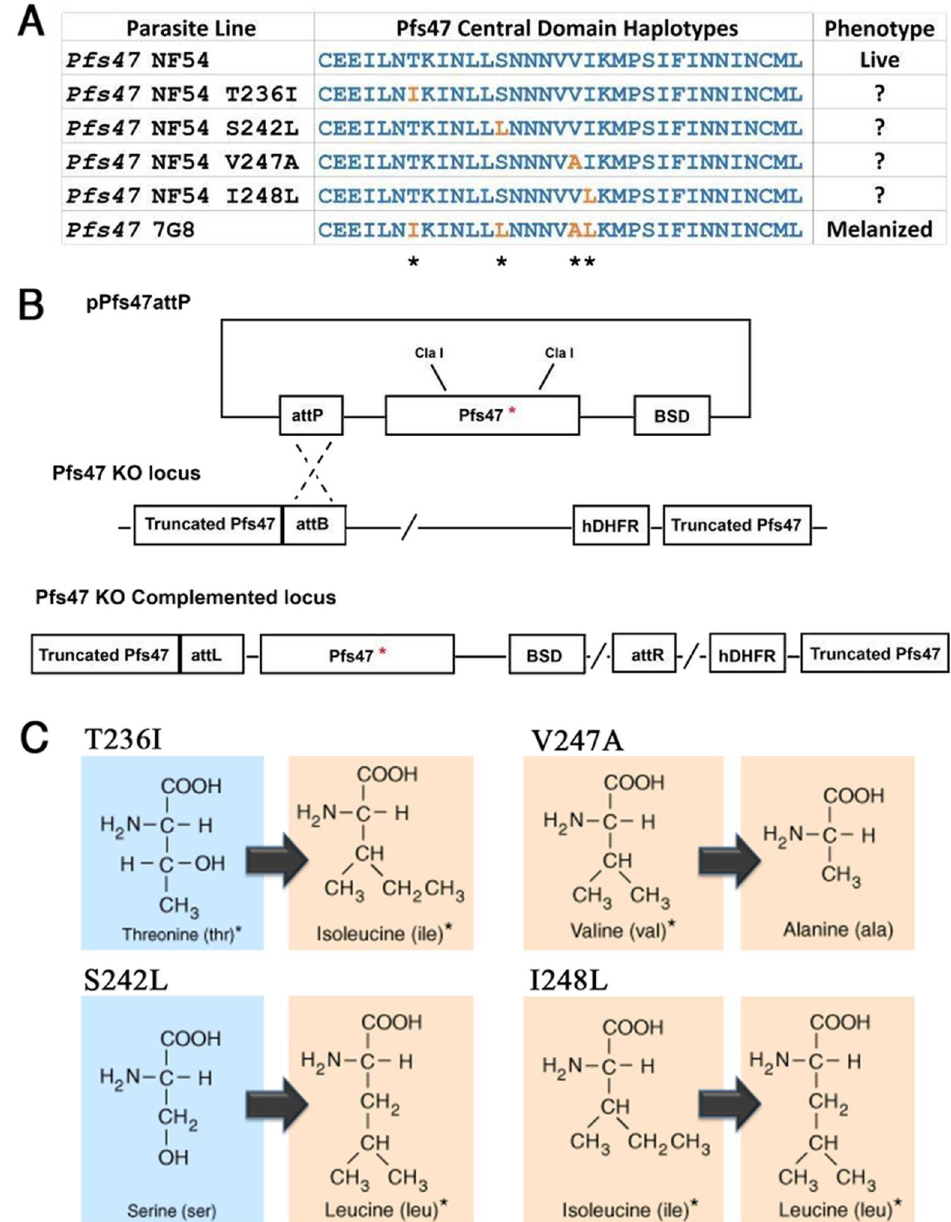
Fig 2. (A) Schematic representation and alignment of Pfs47 Central Domain Haplotypes sequences used in this study. Variablepositionsbetween the NF54 haplotypeand the 7G8 haplotypealong with the point mutationsconstructs used in this study to complement the Pfs47KO line are marked as orange. The known infectionphenotype of these strains in the A . gambiae R strain midgut is shown on the right. (B) Schematicrepresentation of the integrase-mediatedcomplementation of different Pfs47 haplotypes on the Pfs47KO locus by the plasmidpPfs47attP. The drug selectioncassettes hDHFR and BSD the recombination adaptor sites attP/attB are showed. Representation is not in scale and is for illustrationpurposesonly. (C) Schematicrepresentation of the amino acids substituted on every single Pfs47 point mutation construct. Nucleophilic amino acids are shaded in cyan and hydrophobicamino acids are shaded in orange.